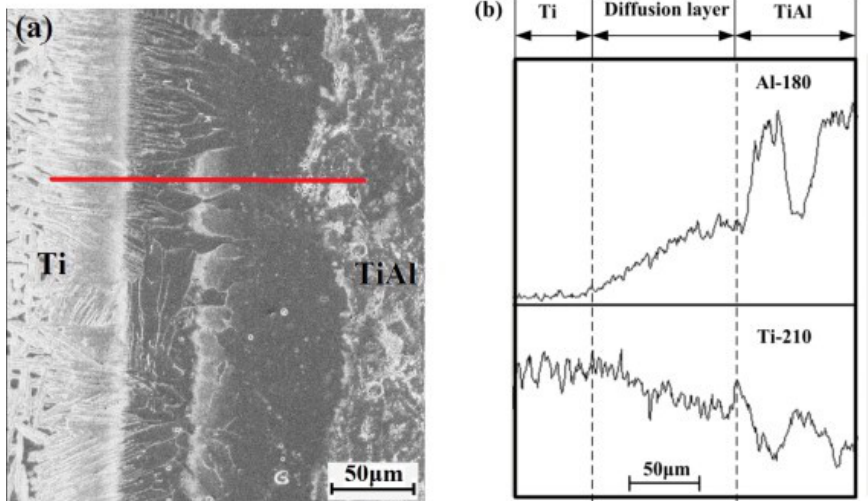
Figure 14. ( a ) Microstructure of the interface between TiAl/Ti and ( b ) EDS analysis across the interface. (Reprinted with permission from [125]. Copyright 2012,